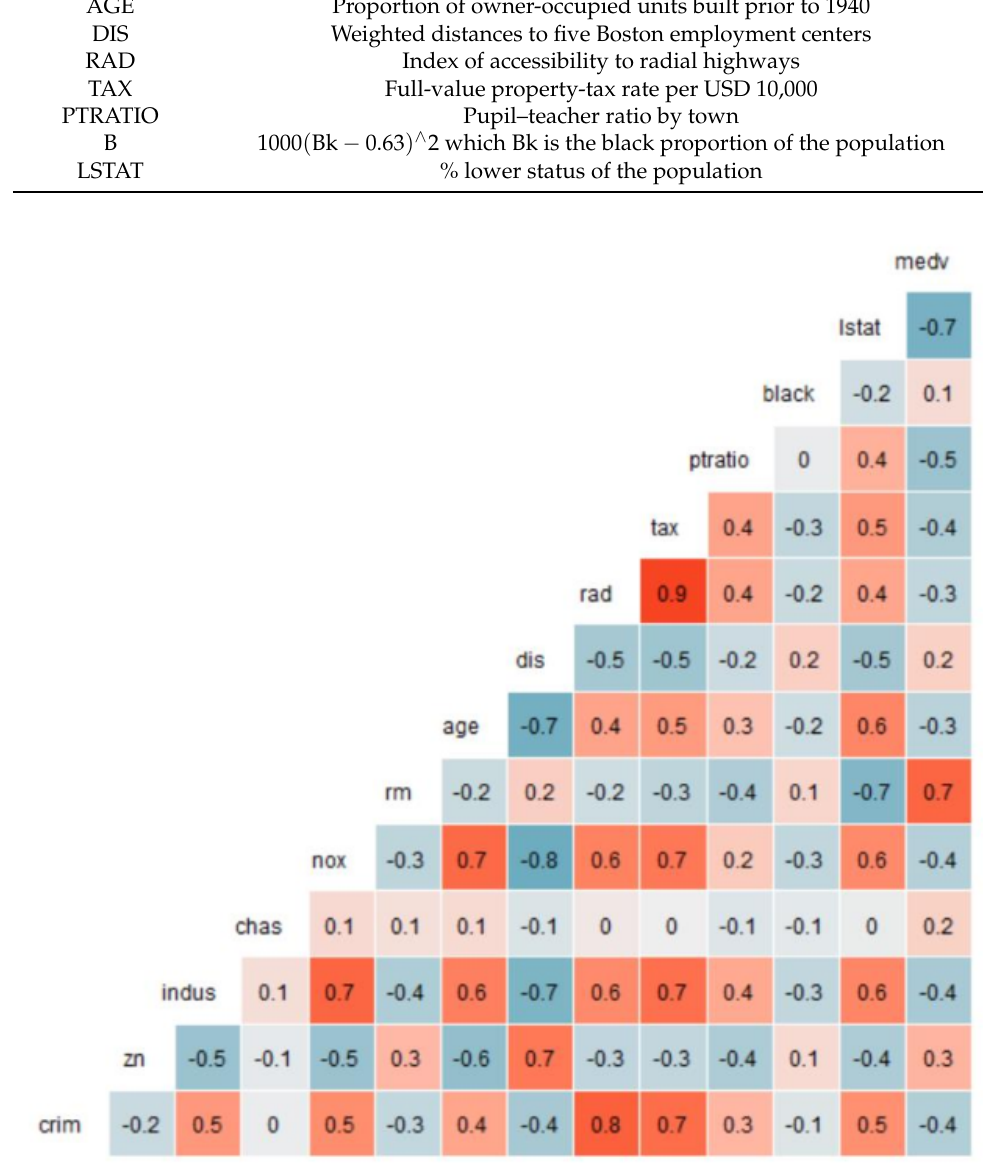
Figure 3. Heat map between the